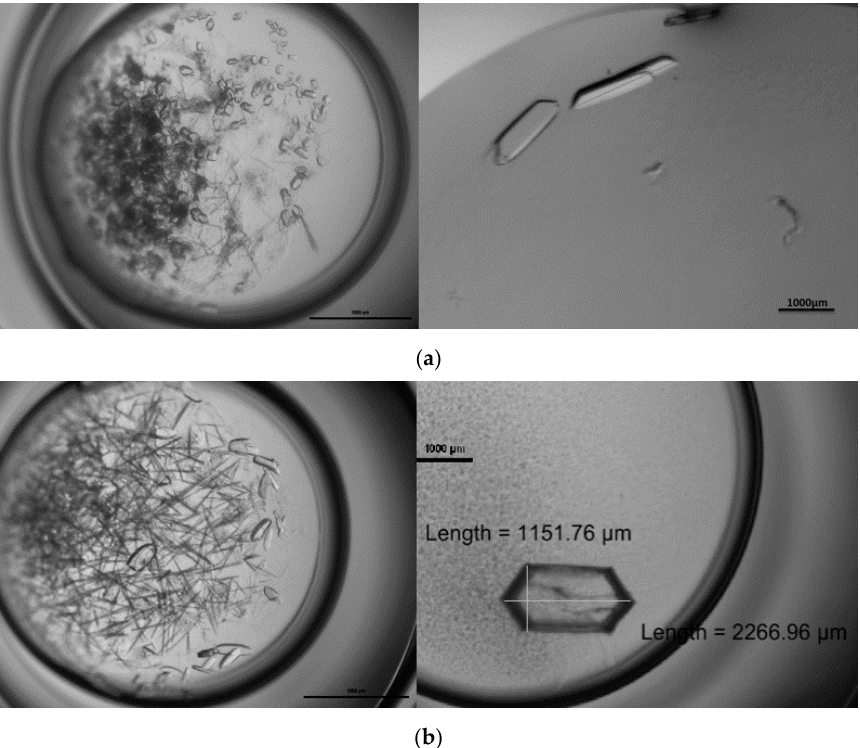
Figure 8. The effect of a magnetic field on nucleation. Crystal growth ( a ) without and ( b ) with a magnetic field using a 96-well plate. magnetic field using a 96-well